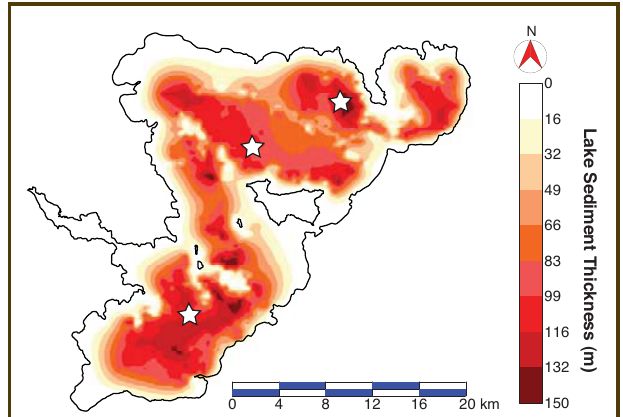
Figure 4. Coring targets (indicated by stars) overlain on a map of the thickness of stratified lacustrine sediment (Wattrus and Russell,